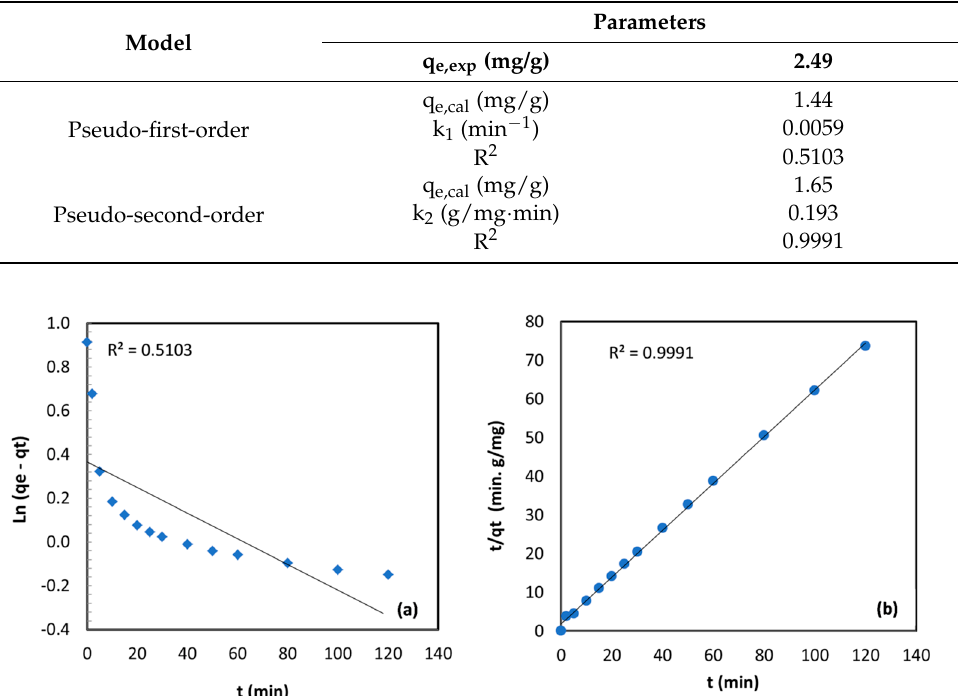
Table 3. Kinetic models constant parameters and correlation coefficient.